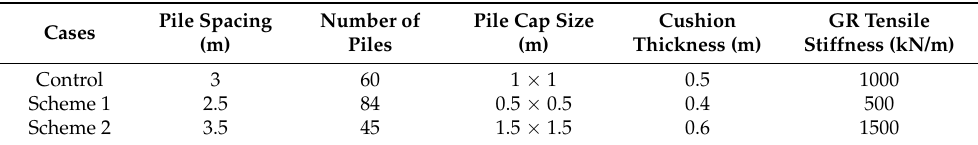
Table 5. Design details of GRPSE system used in this study.